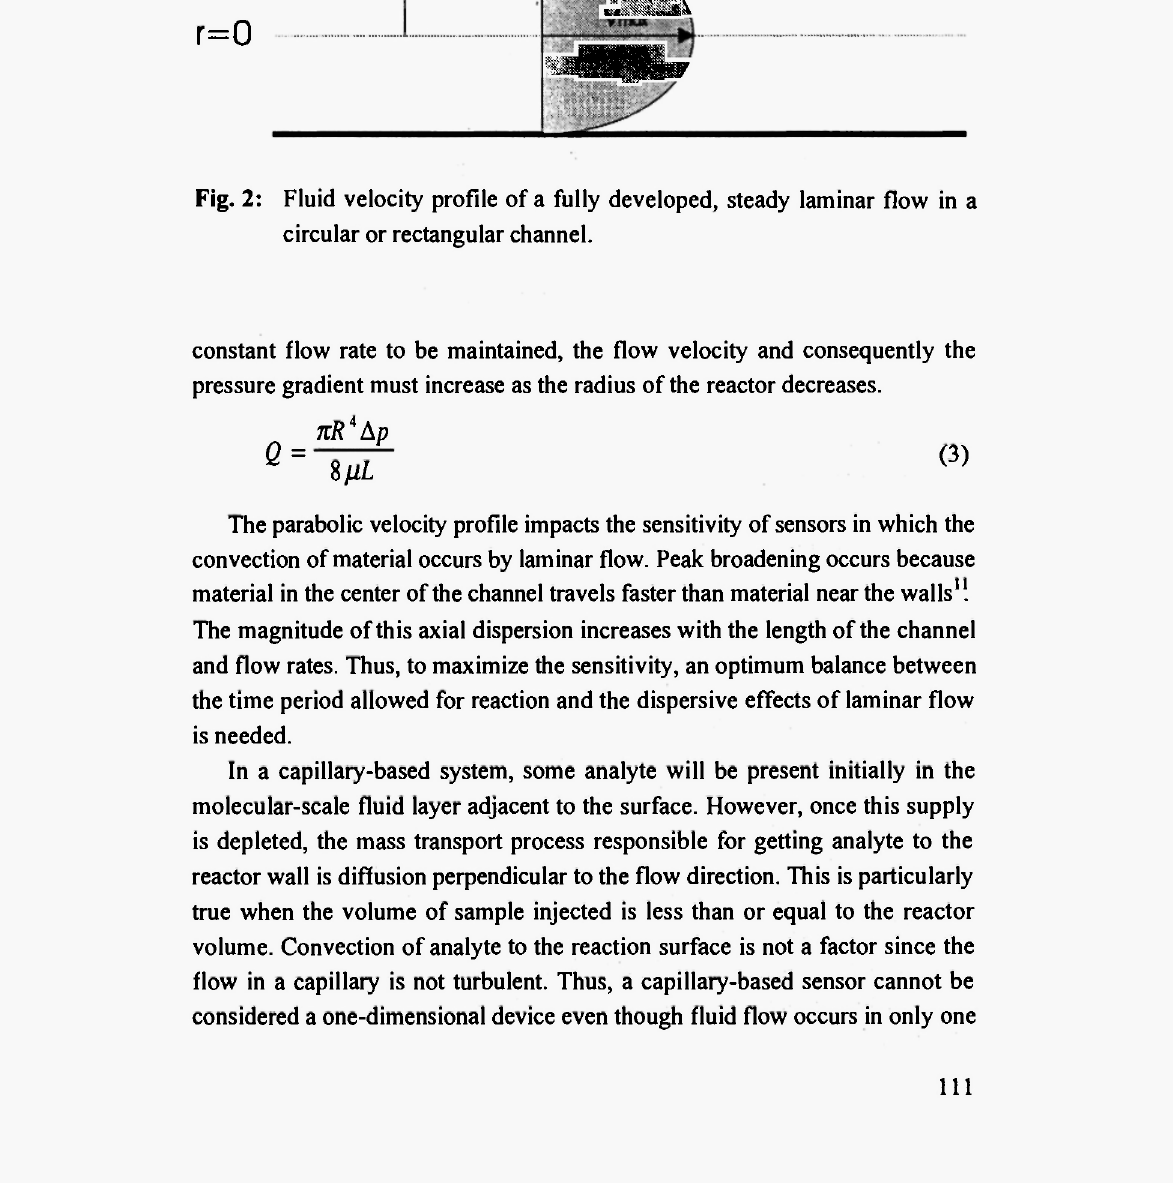
Fig. 2: Fluid velocity profile of a fully developed, steady laminar flow in a circular or rectangular